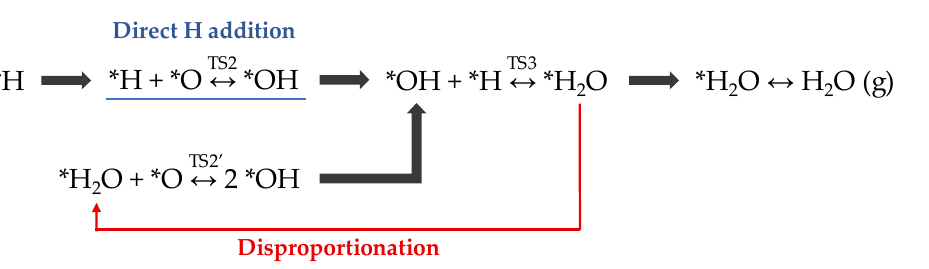
Figure 2. Dual-path reaction mechanism of water formation reaction (WFR) reported on the Pt(111) surface. * indicates the species adsorbed on the platinum surface.